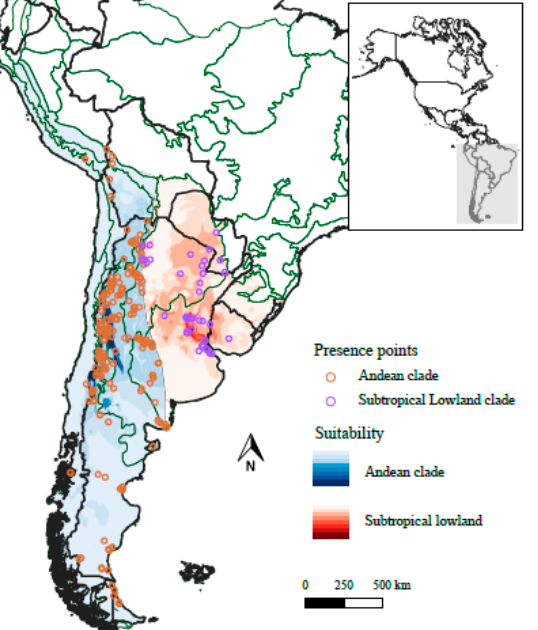
Figure 1. Environmental suitability and occurrence map of the nightshade genus Jaborosa Juss. The darkest color shades represent the areas with the highest suitability values for the Andean (blue) and Subtropical Lowland (red) clades. Phytogeographical regions (green lines) correspond to those provided by [73]. National boundaries delimited with black lines were obtained from [74].